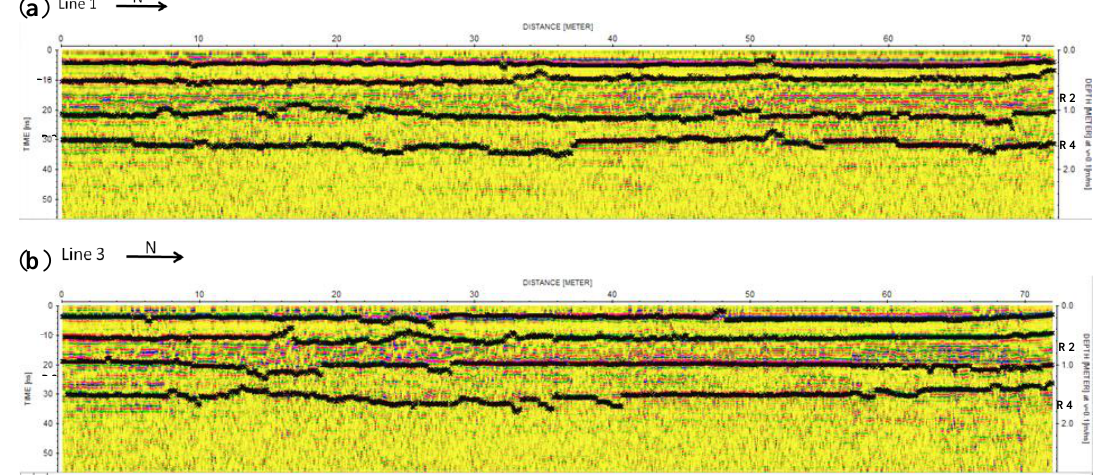
Figure 6. GPR profiles acquired with the 600 MHz antenna along ( a ) the first strip and ( b ) the third strip.